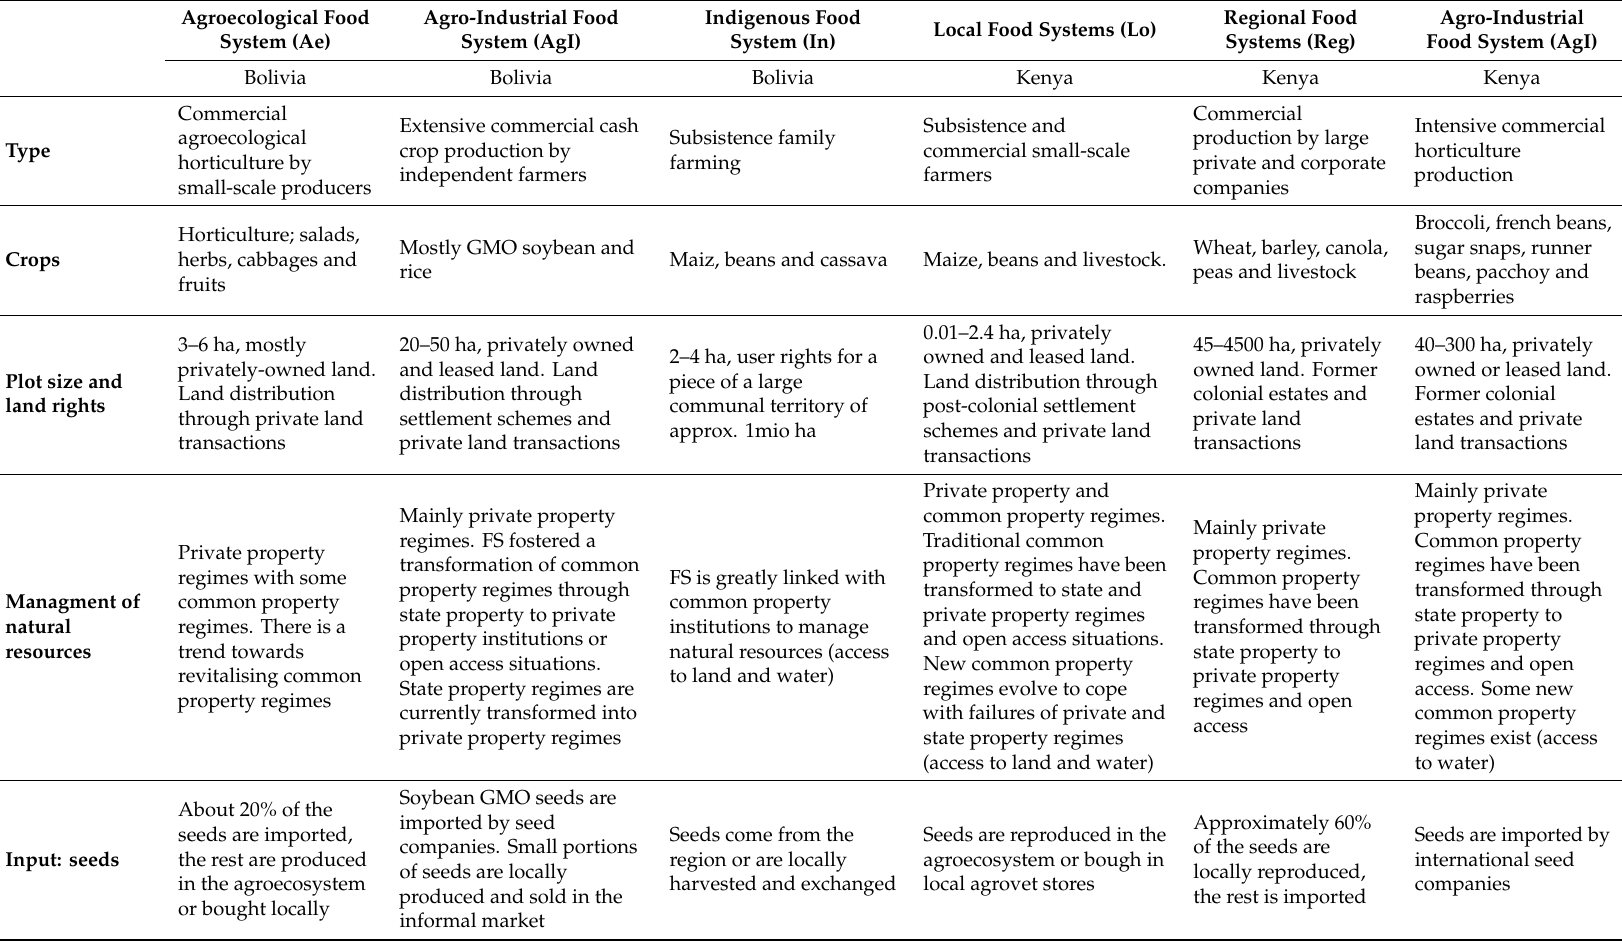
Table 1. Food system characteristics of the food systems in Bolivia and